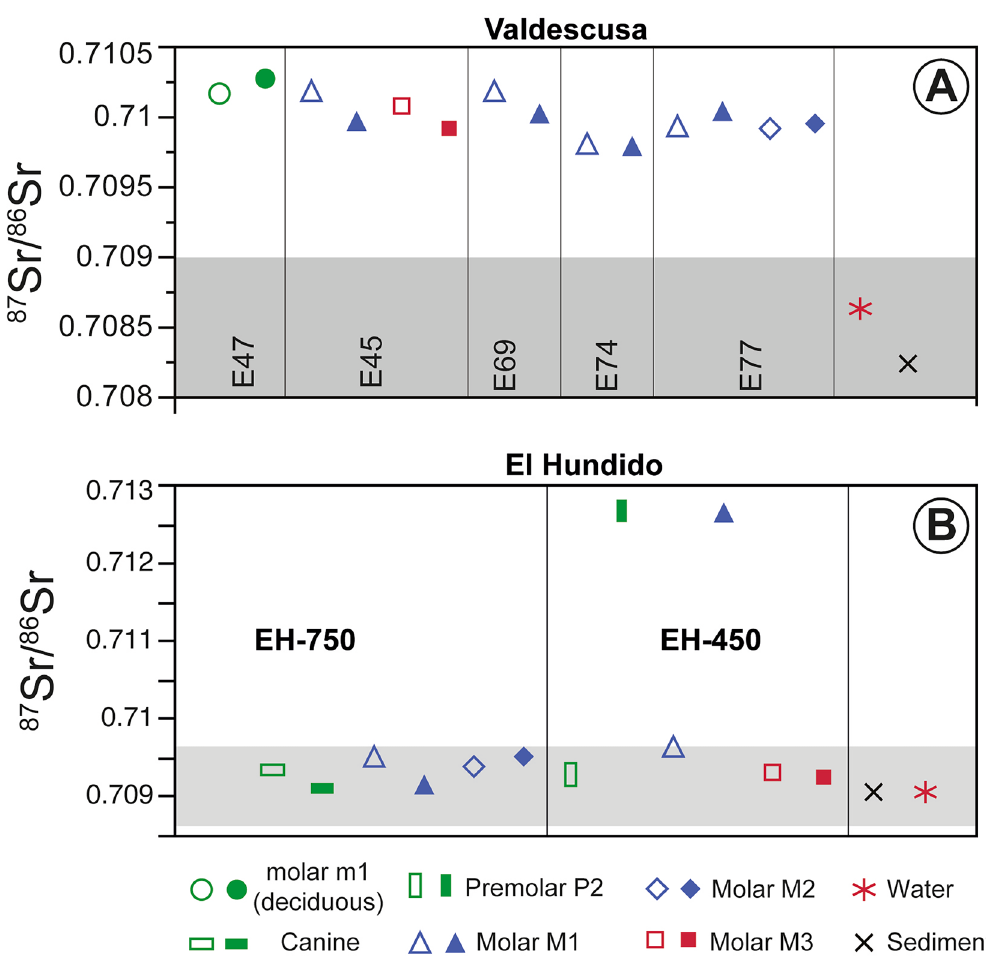
Figure 3. Strontium isotope ratios of tooth enamel and dentine, water and sediments close to the sites. The grey area corresponds to the local bioavailable strontium isotope signature range calculated as ± 1.5 IQR (interquartile range) of the median of sediments and water